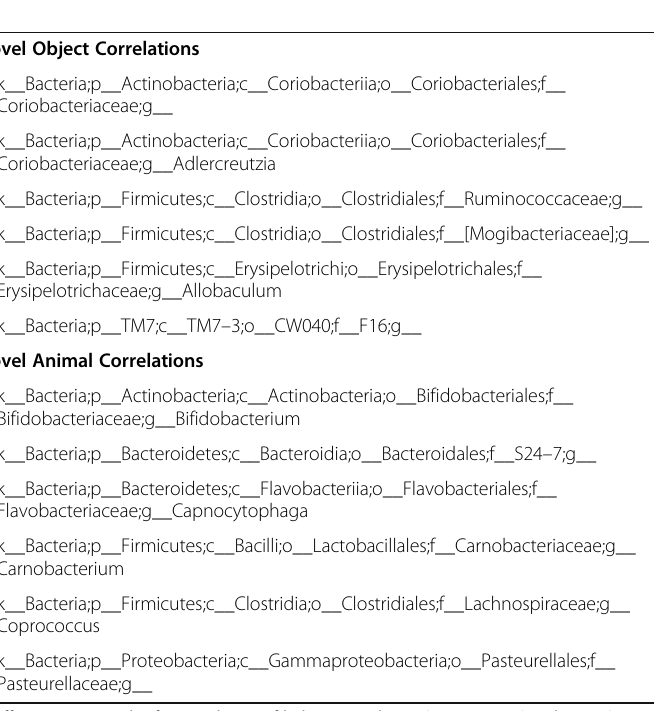
Table 5 Correlation of OTUs and novelty behavior Novel Object